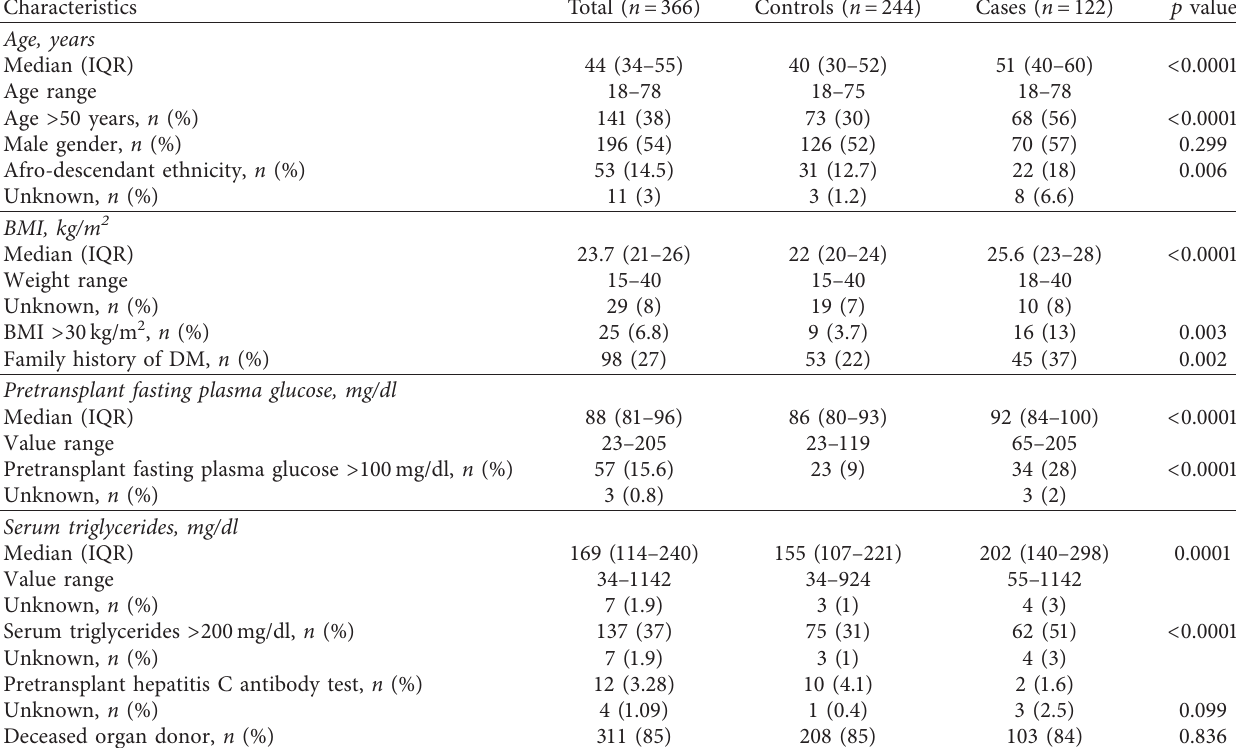
Table 1: Demographic and clinical characteristics of patients with renal transplantation between 1995 and 2014. Characteristics